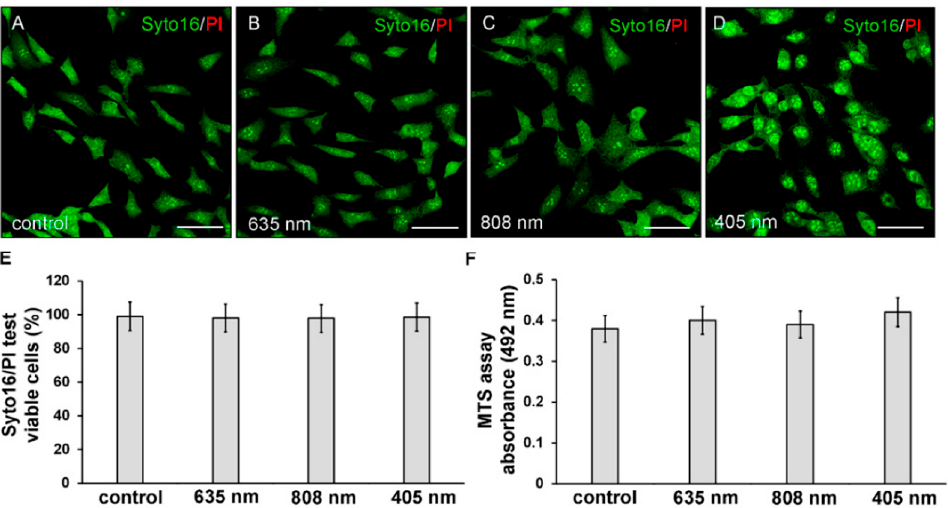
Figure 2. Evaluation of cell viability of NIH/3T3 fibroblasts performed 24 h after cell exposure to red (635 nm), NIR (808 nm) and violet-blue (405 nm) PBM. Cells not subjected to PBM treatments served as control. (A – E) Syto16/PI test. ( A – D ) Representative confocal fluorescence micrographs of cells stained for Syto16 (green) and PI (red). Scale bar: 50 μ m. ( E , F ) Histograms displaying ( E) the morphometric analysis of the percentage of Syto16 positive viable cells and ( F ) the absorbance of colored formazan formed by viable cells. p > 0.05.